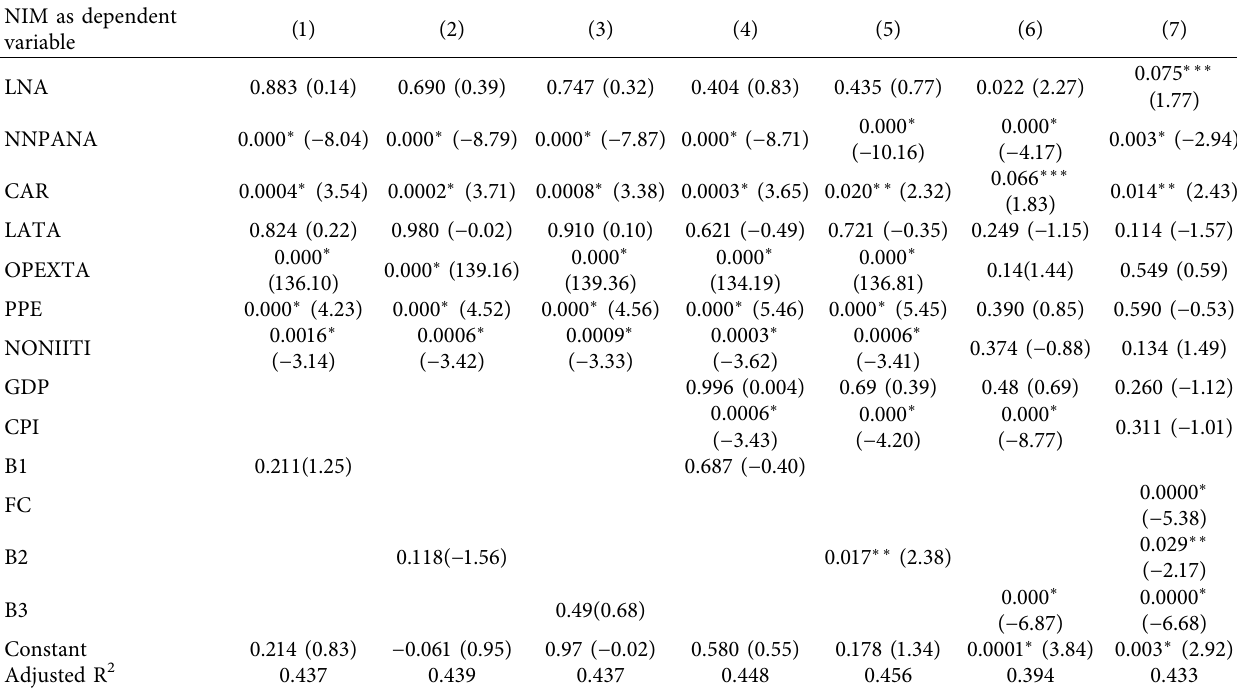
Table 6: Robust regression analysis with net interest margin.